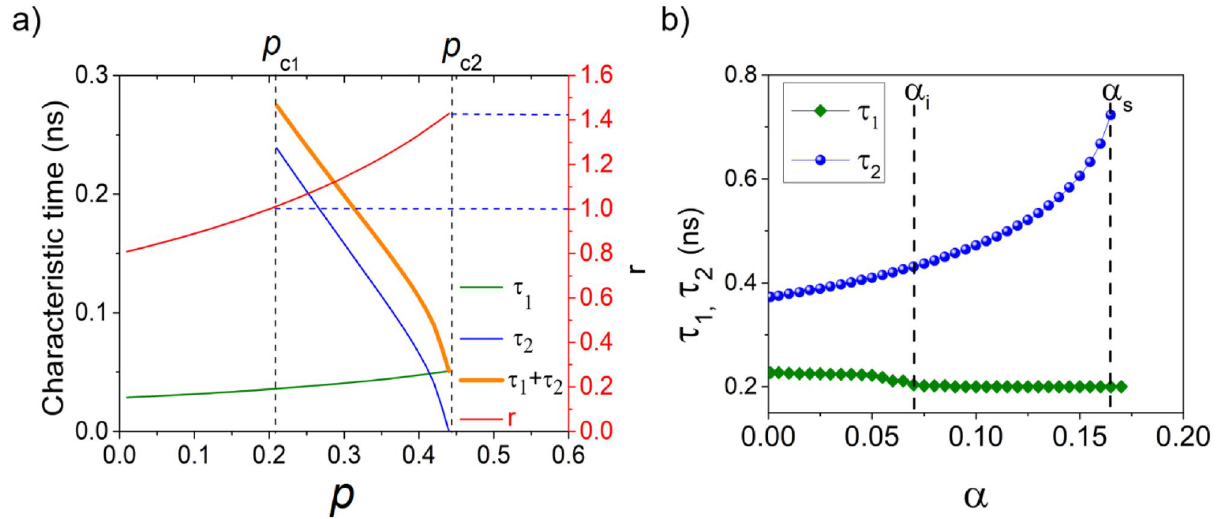
Figure 6. ( a ) Characteristic switching times dependence on r and ξ for a H ip = 0.0324 T, from analytical estimation (α = 0); ( b ) Characteristic times and dependence on damping, for a pulse duration of 0.65 ns, p = 0.35 and H ip = 0.0324